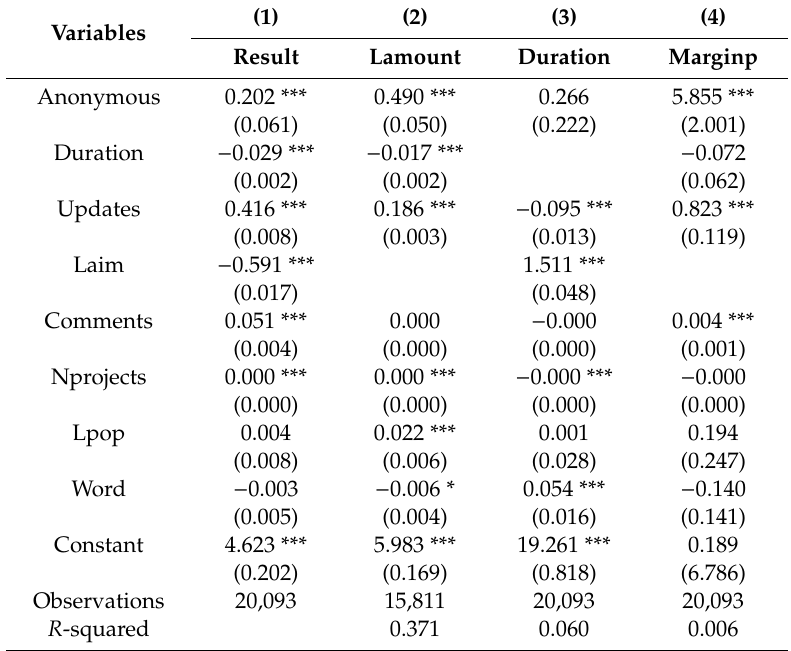
Table 13. Anonymous initiators. This table reports results of regression analysis of the success, amount raised, duration, and margin (%) variables when the initiator is an anonymous individual. We controlled for di ff erent variables. Table 3 defines all the